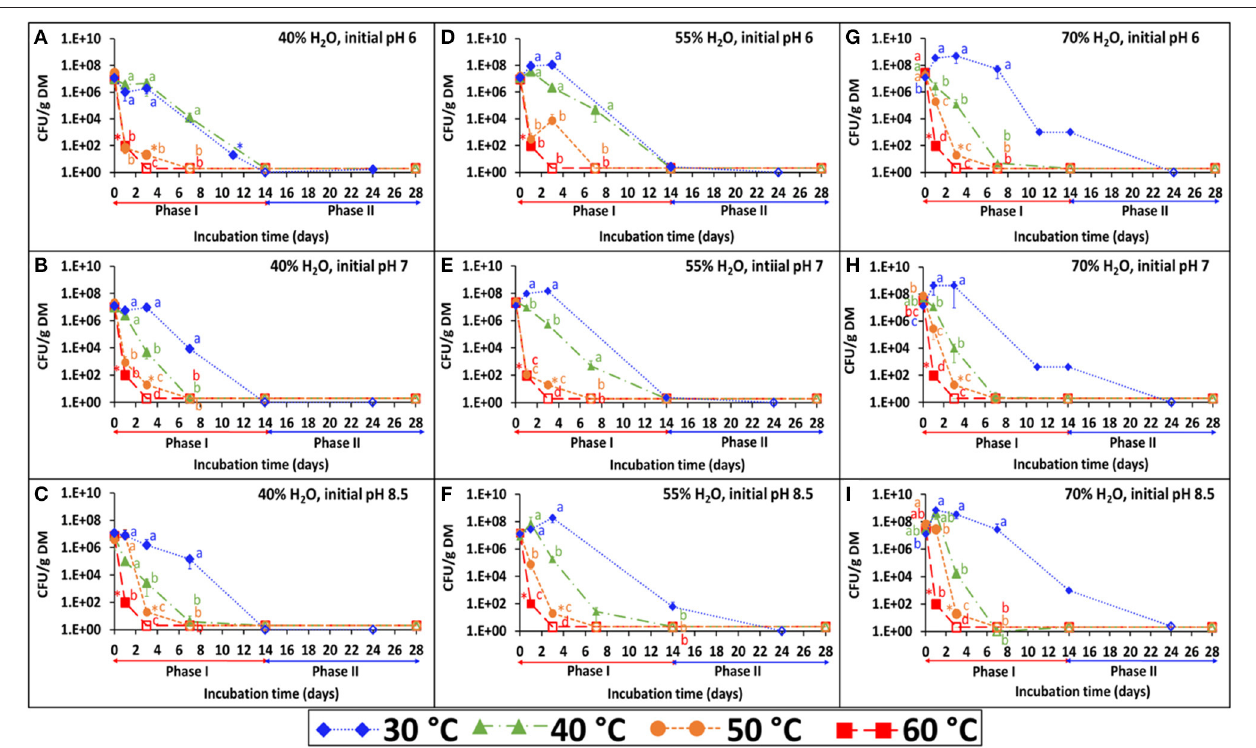
FIGURE 1 | Persistence of S . Infantis in broiler litter (BL) incubated at different temperatures (30, 40, 50, and 60 ◦ C), water content (40, 55, and 70%) and initial pH (6, 7, and 8.5). The different incubation temperatures were applied during phase I (weeks 1–2), while at phase II (weeks 3–4) the incubation temperature was 30 ◦ C. Error bars represent the standard deviations of triplicate vessels. Letters denote significant differences between treatments at time intervals (log-transformed CFU values; Tukey-Kramer HSD; P ≤ 0.05). Empty symbols indicate values below the detection limit after enrichment (1–2 CFU g − 1 dry matter); *values below the detection limit without enrichment (10–20 CFU g − 1 dry matter). The figures are grouped according to water contents of 40% (A–C) , 55% (D–F) , and 70% (G–I) . DM, dry